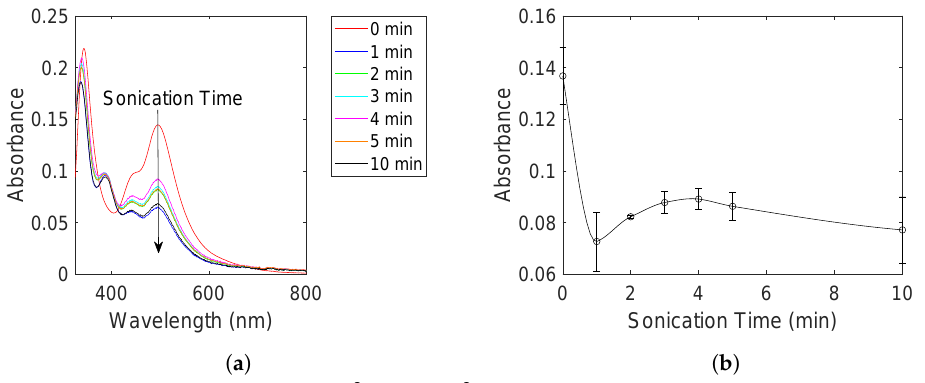
Figure 2. Absorbance spectra of PtI 62– and PtI 42– at different sonication times ( a ) and the absorbance at 495 nm plotted as a function of sonication time ( b ). The sonication time is measured in minutes after the addition of PtCl 4 to the Cu-solution. The contribution from other interfering species such as the carbon support and the as-formed nanoparticles were removed by